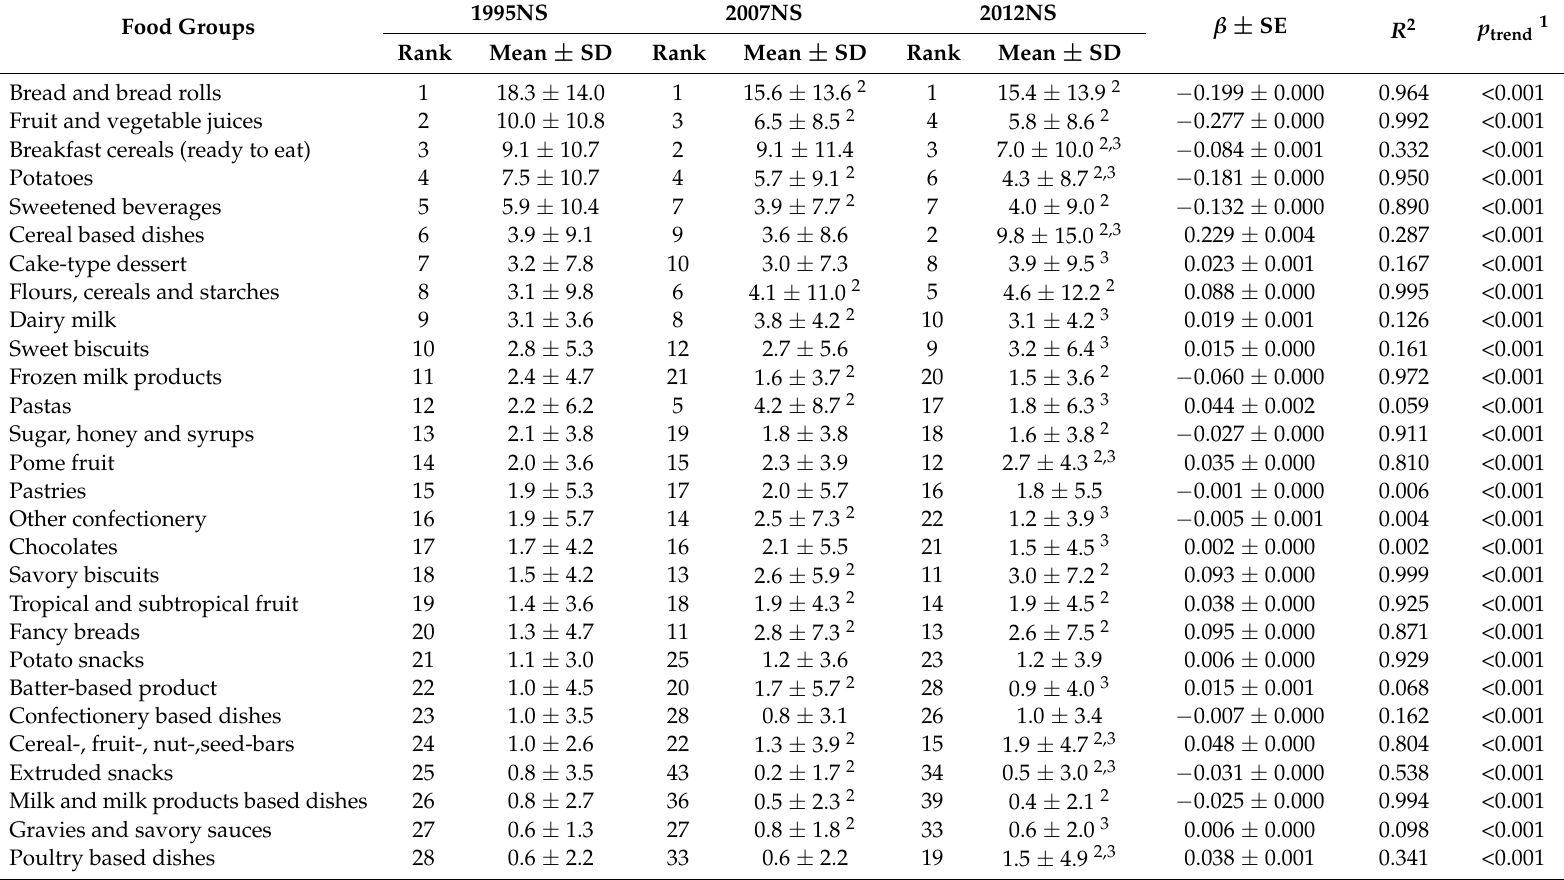
Table A2. Per capita mean ± SD comparison of the highest contributors to glycemic load in the three surveys—all subjects included. Food